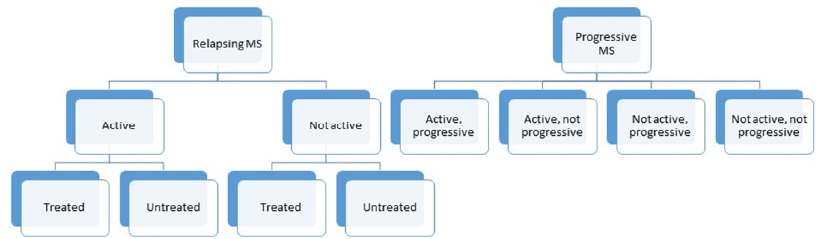
Figure 1. The new phenotypic classification of multiple sclerosis. MS, multiple